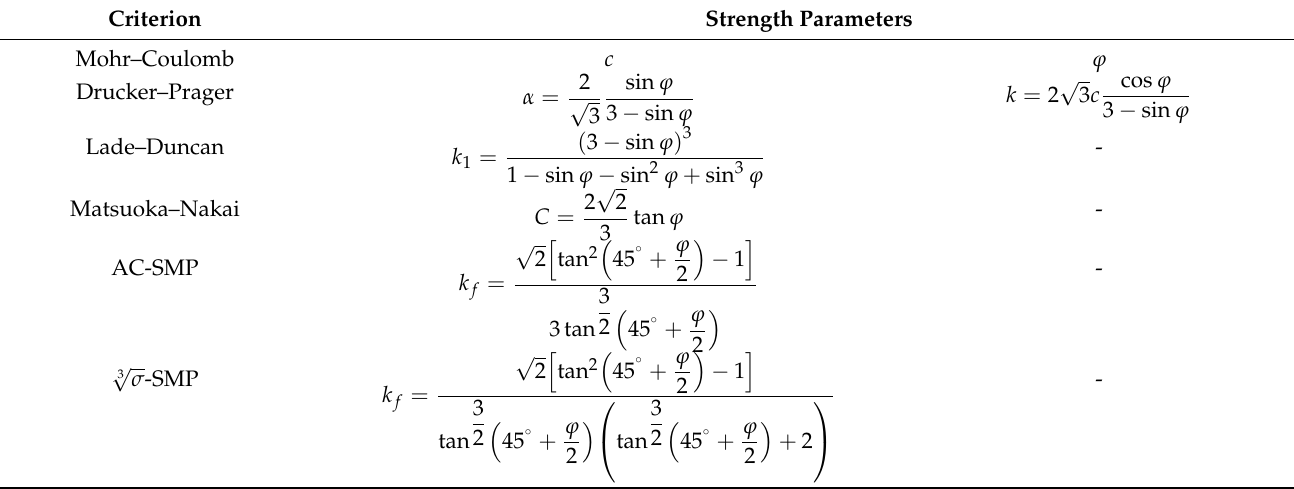
Table 3. Strength parameter values of different strength